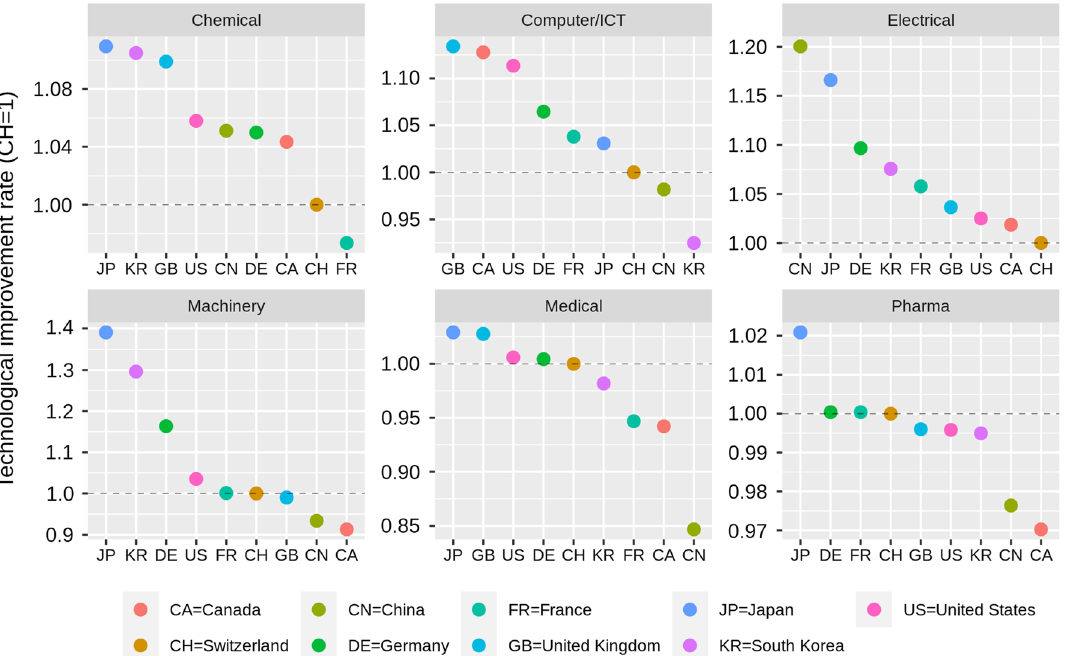
Fig. 9 Average technological improvement rates for non-digital patents across industries and countries. Notes : Calculations based on improvement rates of 1757 technologies taken from Singh et al. (2021) and the definition for digital IPC classes from Inaba and Squicciarini (2017) that were both matched to USPTO patents between 2010 and 2015. The average technological improvement rate is normalized according to the value of